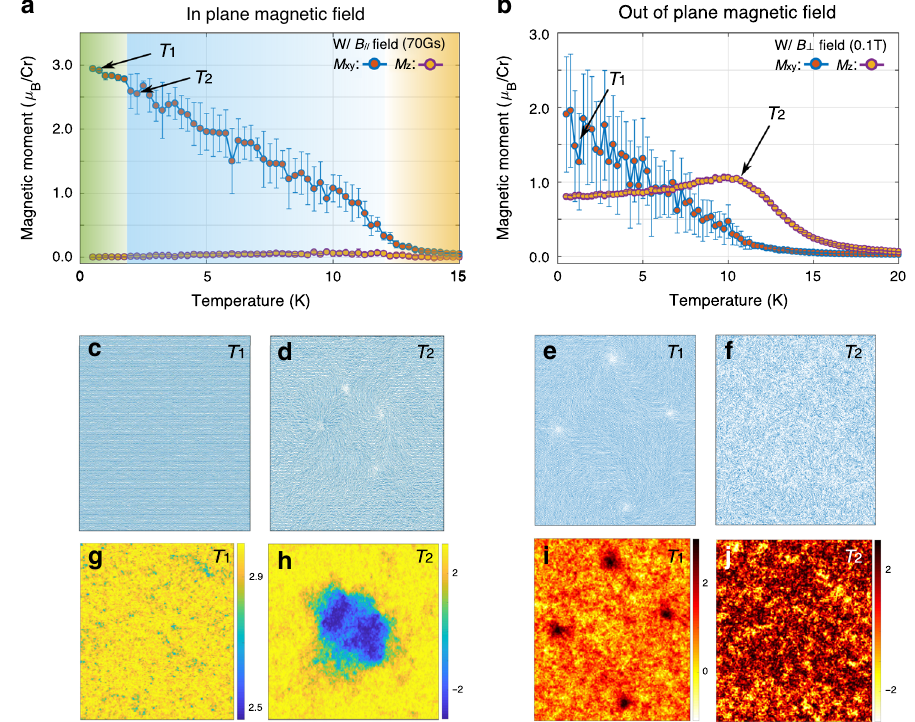
Fig. 4 Response of the spin structures to external magnetic fi eld. a , b Magnetic polarization versus temperature under parallel and perpendicular external magnetic fi elds, respectively. The different background colors in ( a ) indicate different magnetic states. c – f Real-space magnetic moments under the marked temperatures in ( a , b ). The lower panels ( g – j ) are the corresponding projection components of local magnetic moments along external fi eld directions (parallel and perpendicular to the material plane, respectively) from ( c – f ). The error bars are the standard